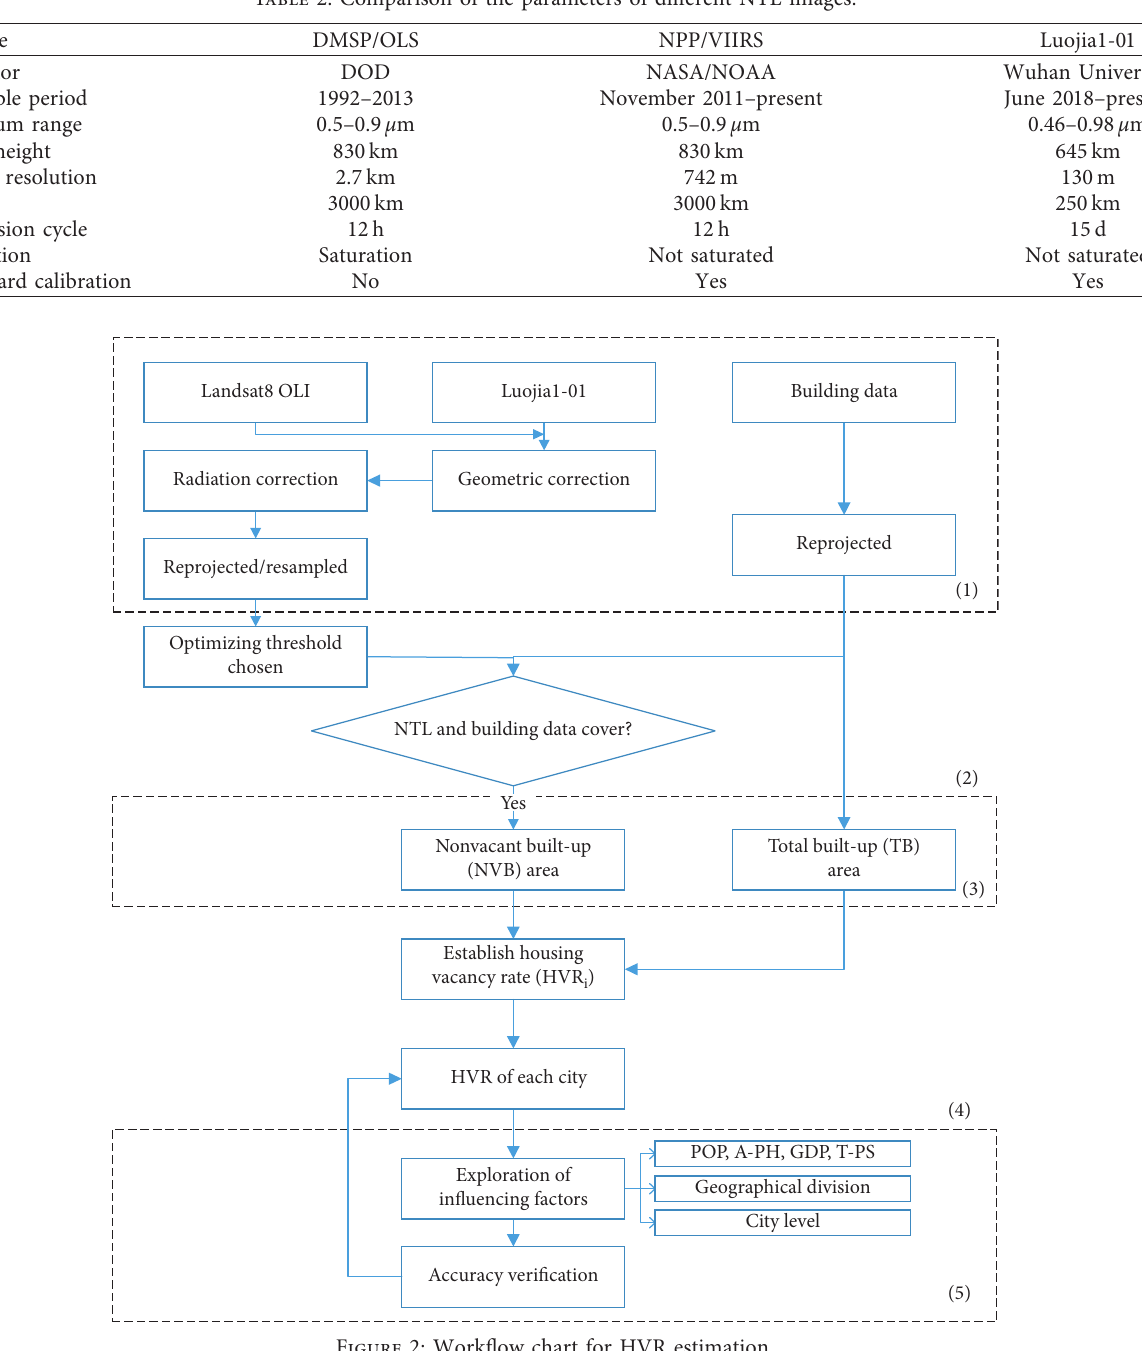
Table 2: Comparison of the parameters of different NTL images.